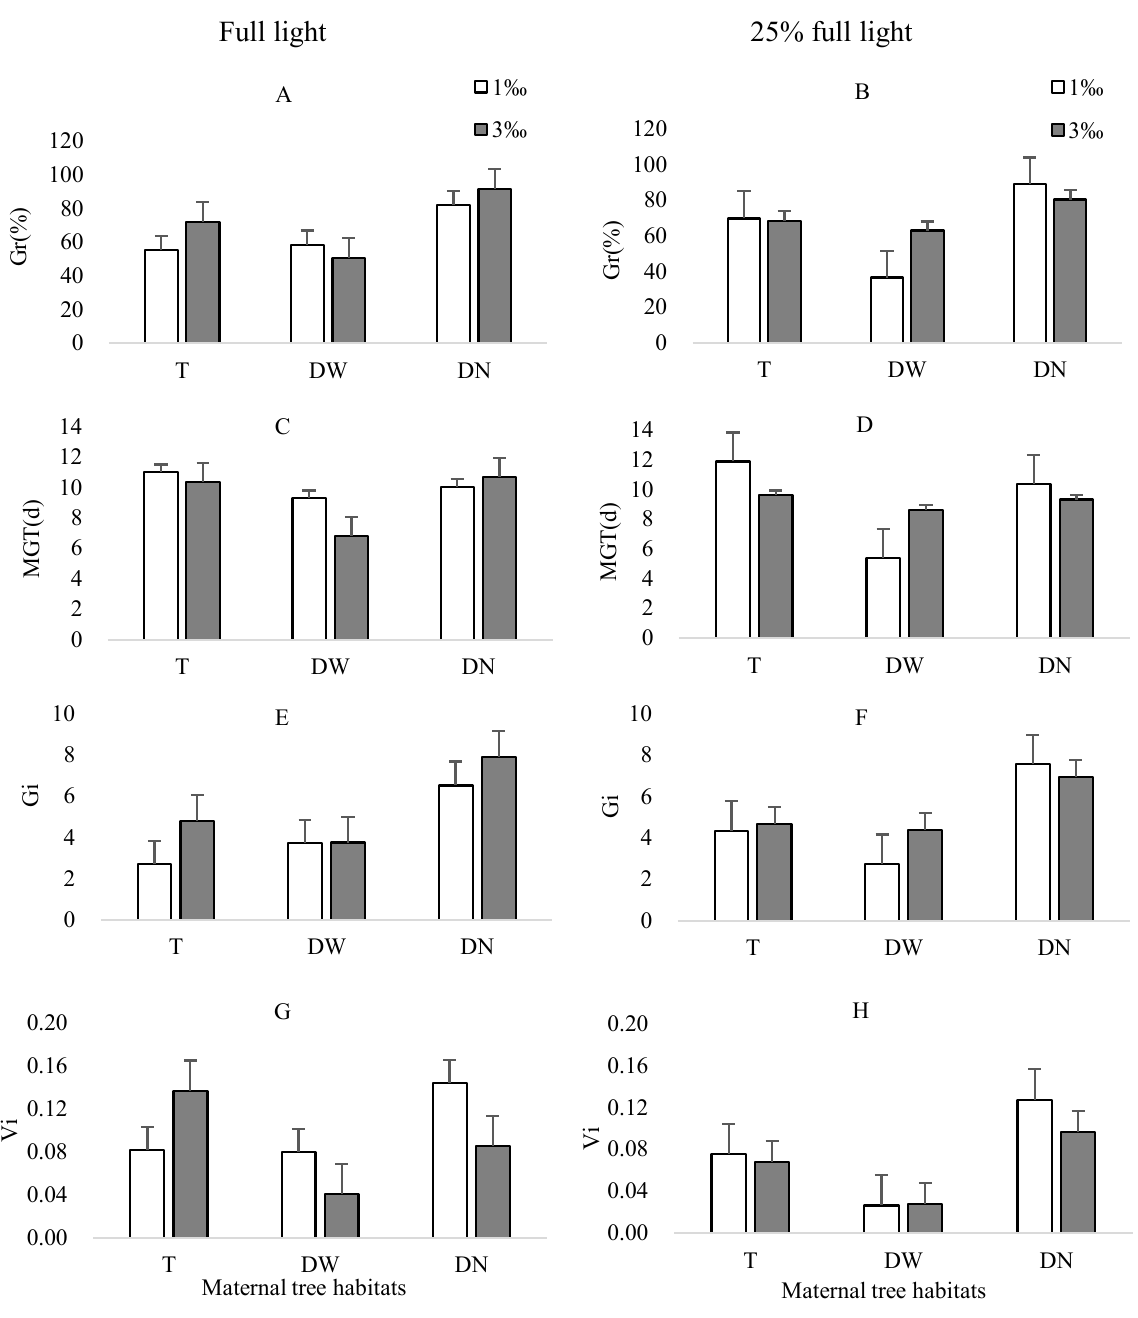
Figure 4. Effects of light intensity and salinity on seed germination of Morus alba from different maternal tree habitats. T: seeds from nonsaline soil; DW: seeds from Jiufenchang in saline–alkali land; DN: seeds from Shenxiangou in saline–alkali land. ( A ): Gr, full light; ( B ): Gr, 25% full light; ( C ): MGT, full light; ( D ): MGT, 25% full light; ( E ): Gi, full light; ( F ): Gi, 25% full light; ( G ): Vi, full light; ( H ): Vi, 25% full light.